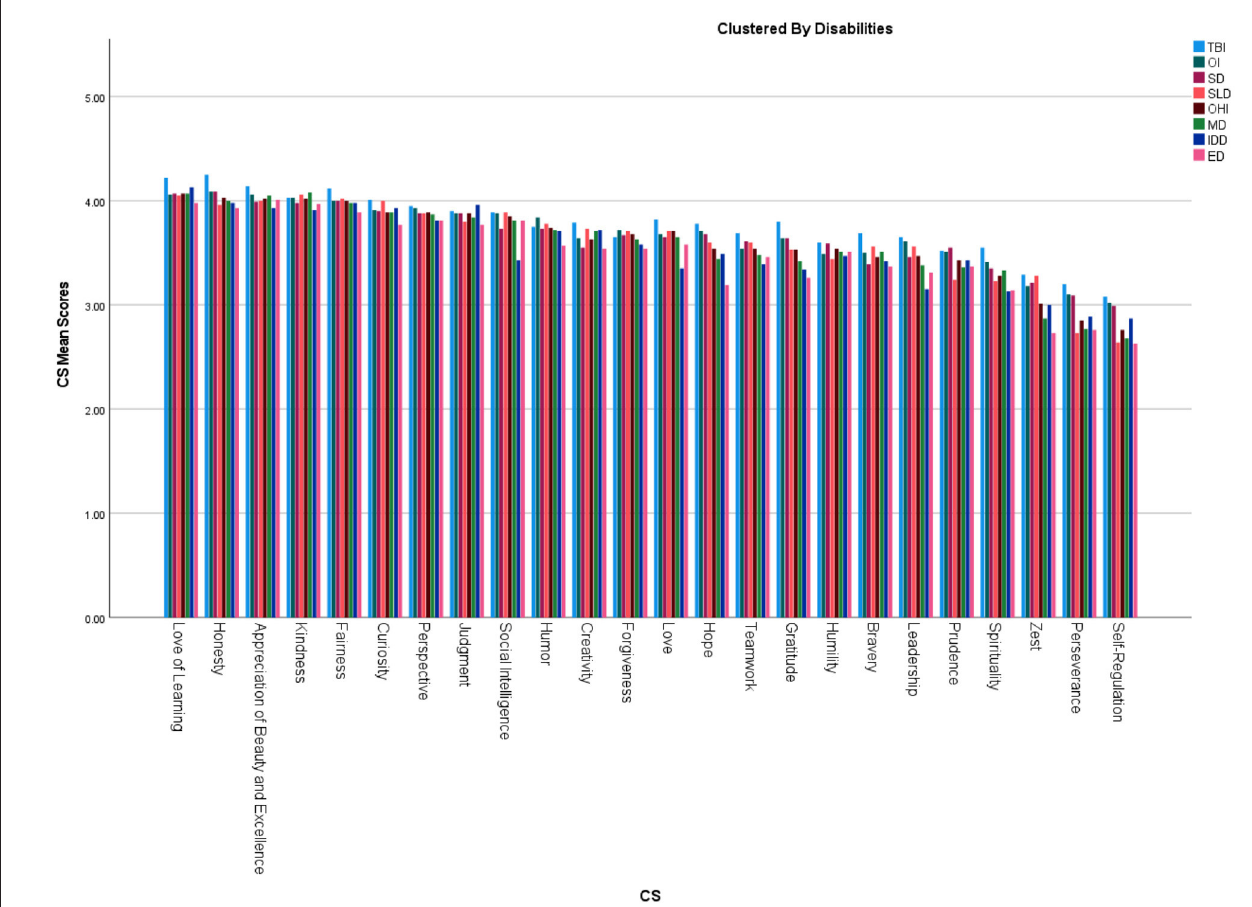
FIGURE 2 | Overall character strengths profile. TBI, Traumatic brain injury; OI, Orthopedic impairment; SD, Sensory disabilities; SLD, Speech-language disabilities; OHI, Other health impairments; MD, multiple disabilities; IDD, Intellectual disabilities; ED, Emotional disturbance.